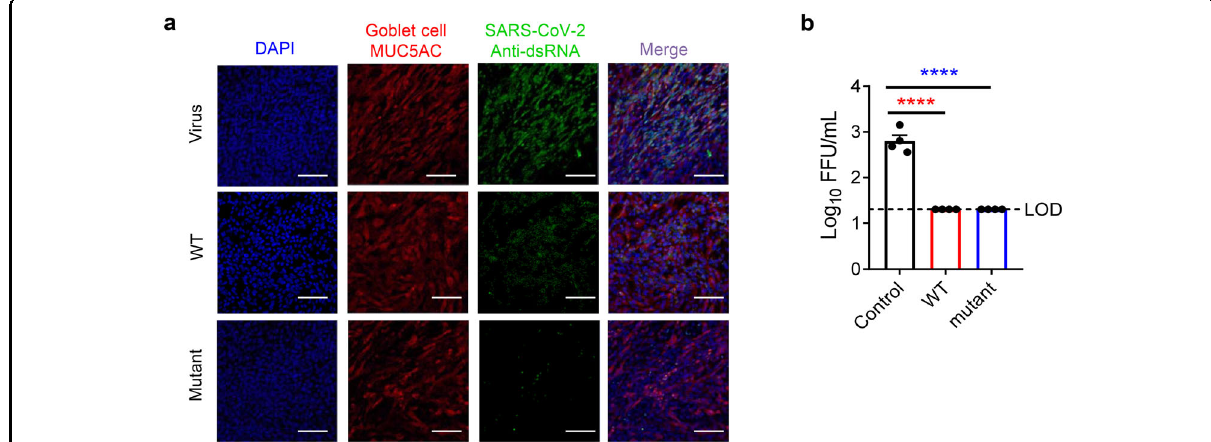
Fig. 3 hACE2-Fc protected HBE from SARS-CoV-2 infection. a At 24 h post SARS-CoV-2 infection, HBE cells were fi xed with 4% paraformaldehyde, followed by immuno fl uorescent staining. SARS-CoV-2 virus (green) and goblet cell (red) were stained with anti-dsRNA monoclonal antibody and anti- mucin 5AC monoclonal antibody, respectively. Nuclei were stained with DAPI (Blue). Scale bars (white), 100 µm. Magni fi cation, ×20. b Cell culture supernatant was collected for virus titering. LOD, limit of detection. Data are representative of four independent experiments. * P ≤ 0.05, ** P ≤ 0.01, *** P ≤ 0.001, **** P ≤